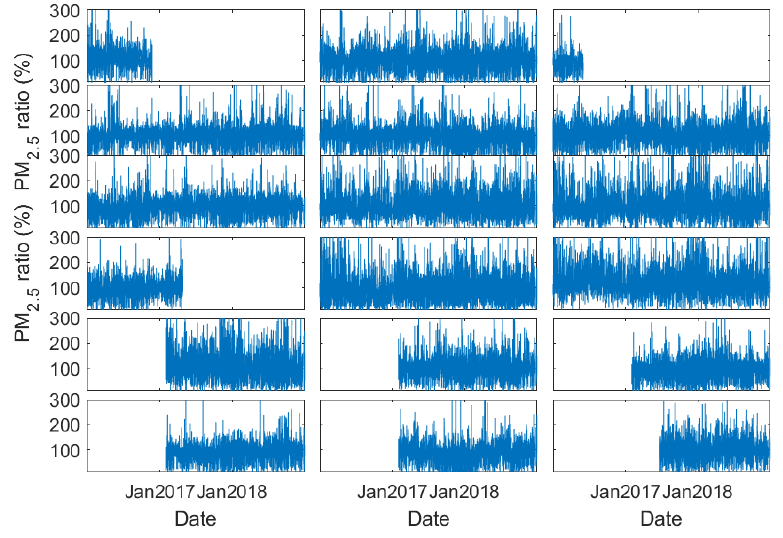
Figure 8. As Figure 7 but for PM 2 . 5 data at 18 stations in Tianjin.